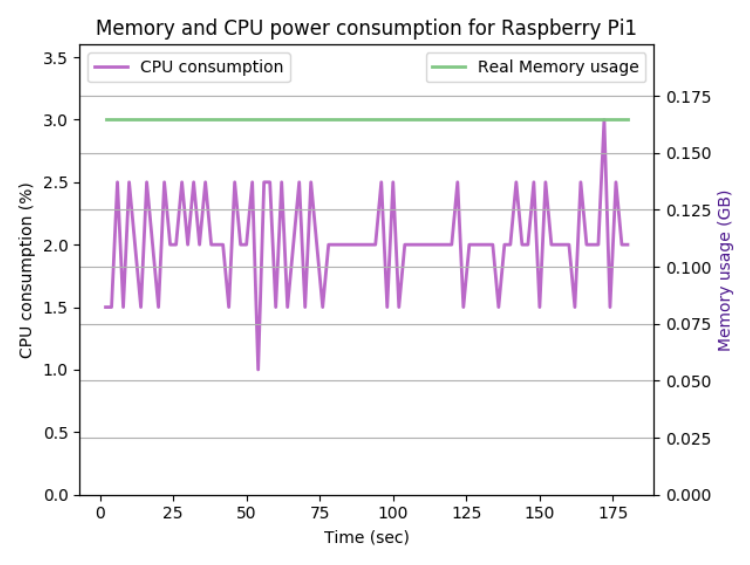
Figure 11. The CPU and memory utilization of the Raspberry Pi device in the idle JVM